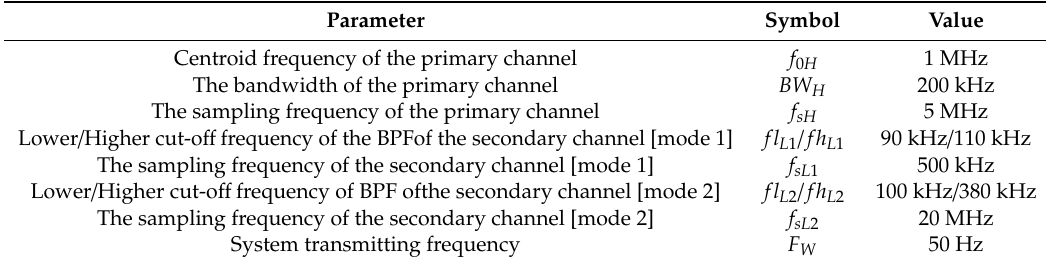
Table 1. The f iltering and sampling parameters. Table 1. The filtering and sampling